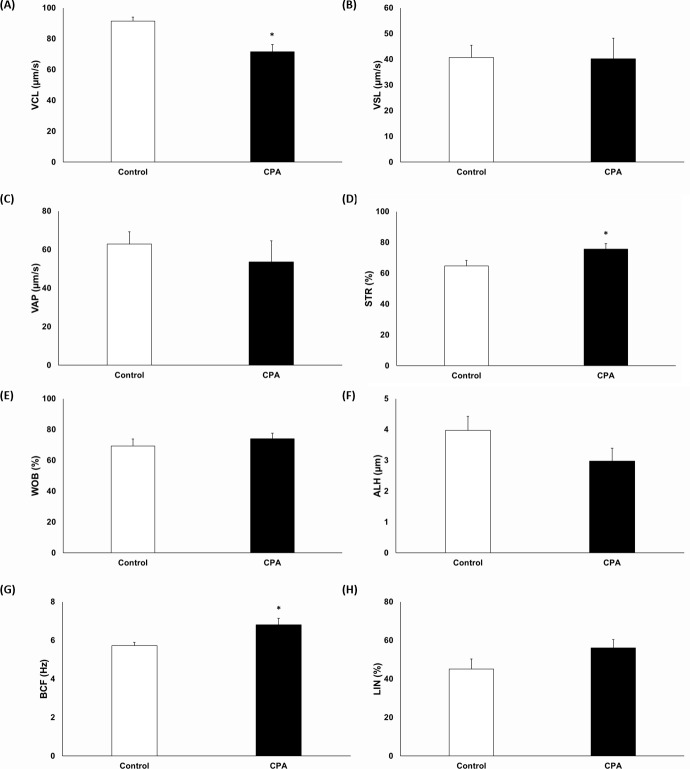
Effects of CPA addition on sperm motion kinematics. (A) Curvilinear velocity, (B) straight-line velocity, (C) average path velocity, (D) straightness, (E) wobble, (F) amplitude of lateral head, (G) beat-cross frequency, and (H) linearity. Data are presented as mean ± SEM. (*p < 0.05, n = 9).